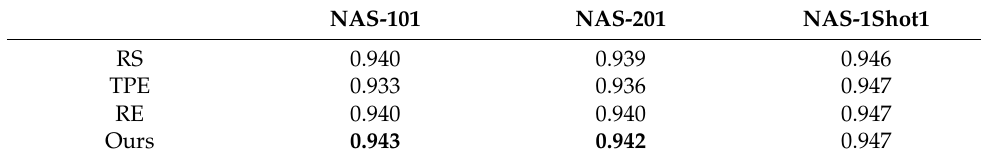
Table 1. Statistical experimental results for NAS-Bench on the Cifar10